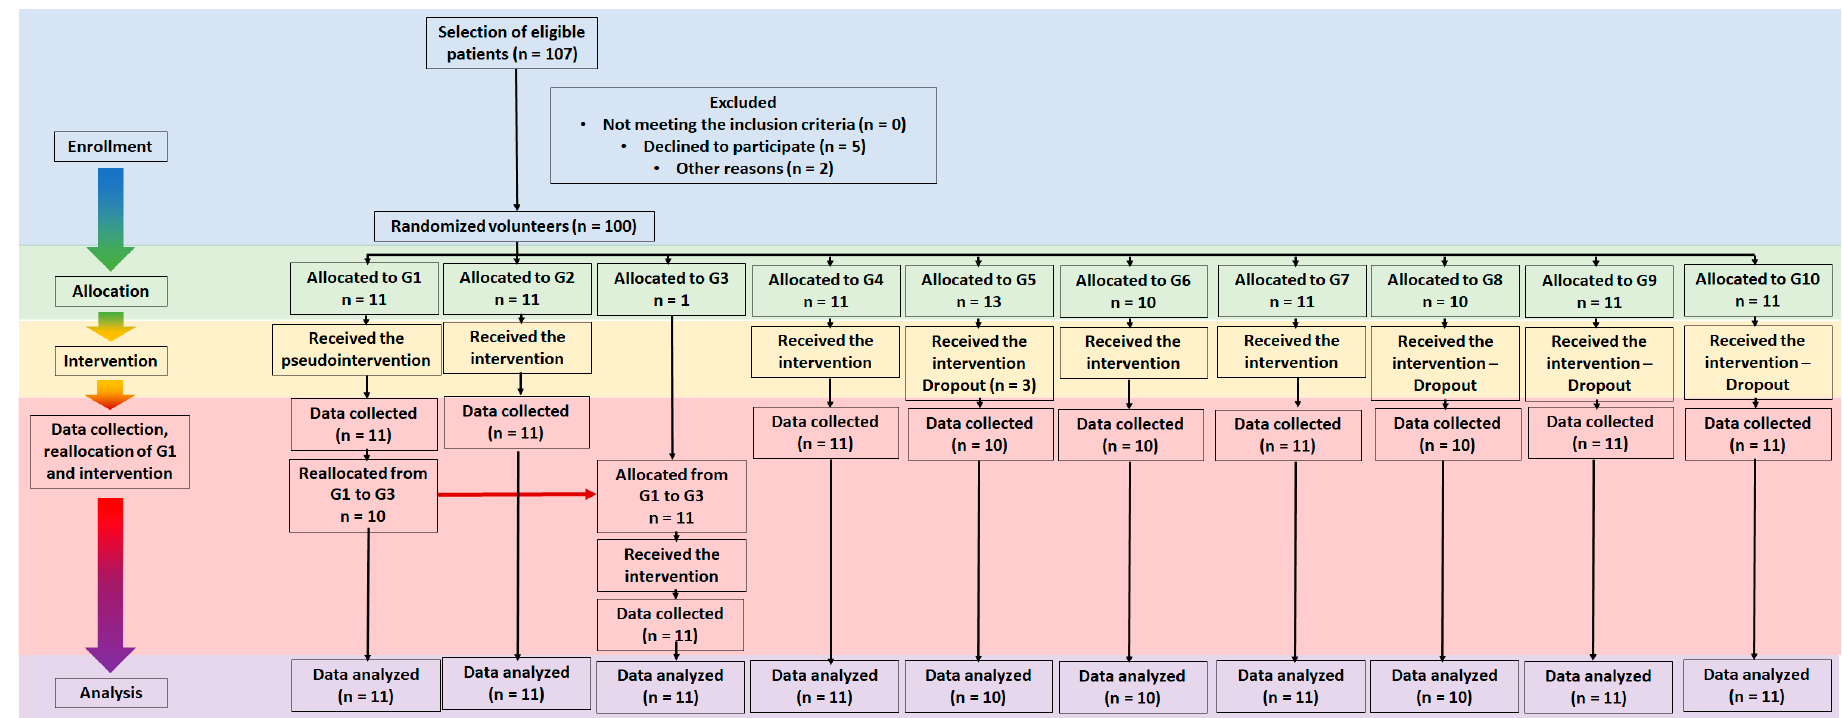
Figure 1. Flowchart of the steps taken throughout this study (CONSORT flow diagram). The flowchart highlights the enrollment of volunteers, their allocation, interventions applied, data collection, reallocation of G1 patients into G3 for subsequent G3 intervention and analysis during the study. Clinical evaluation was carried out in the pre- (T0) and post-treatment period (T1; after 8th session) and 15 days after the treatment has been completely suspended (T2). G1, G2, G3, …, G10 are the study groups from 1 to 10 described in Section 2.2 Study protocol.